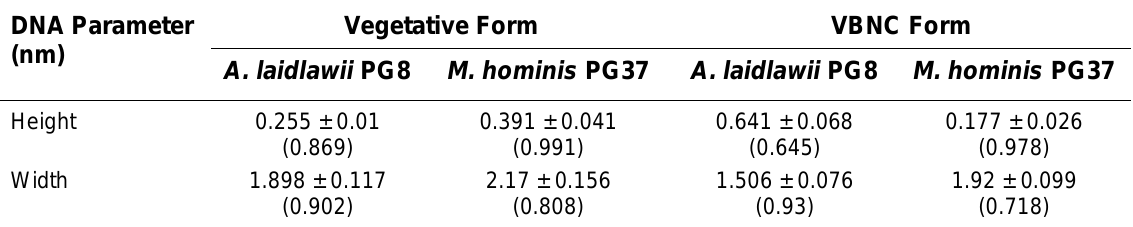
The Measured Height and Width of the DNA Molecules Extracted from A. laidlawii PG8